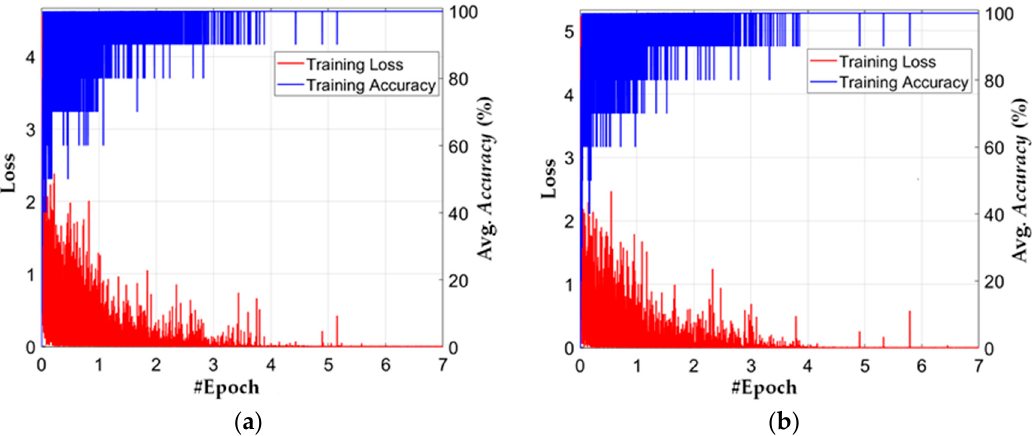
Figure 9. Plot for training loss and accuracy: ( a ) 1-fold cross-validation; ( b ) 2-fold cross-validation.